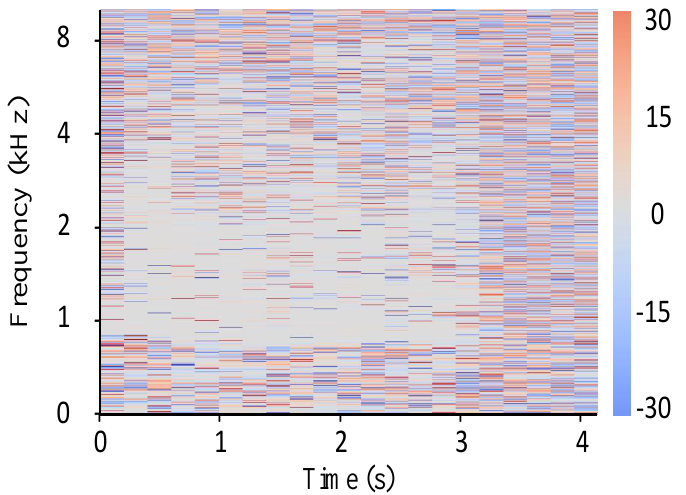
Figure 4. An example of the actual output of IPD where the color map represents the angle (°). The dataset of the simulated IPD includes 400 audio records, 5 spatial sizes (5 × 5, 5 × 6, 6 × 6, 7 × 6, and 7 × 7 m 2 ), 26 sampling points, 5 SNR (0, 5, 10, 20, and 30 dB), 3 RT60 (0.16, 0.36, and 0.61 s), and a total of 780,000 images. The dataset of Real IPD includes: 400 audio records, 1 spatial size (6 × 6 m 2 ), 26 sampling points, 5 SNR (0, 5, 10, 20, and 30 dB), 3 RT60 (0.16, 0.36, and 0.61 s), and a total of 156,000 images. The nature of the